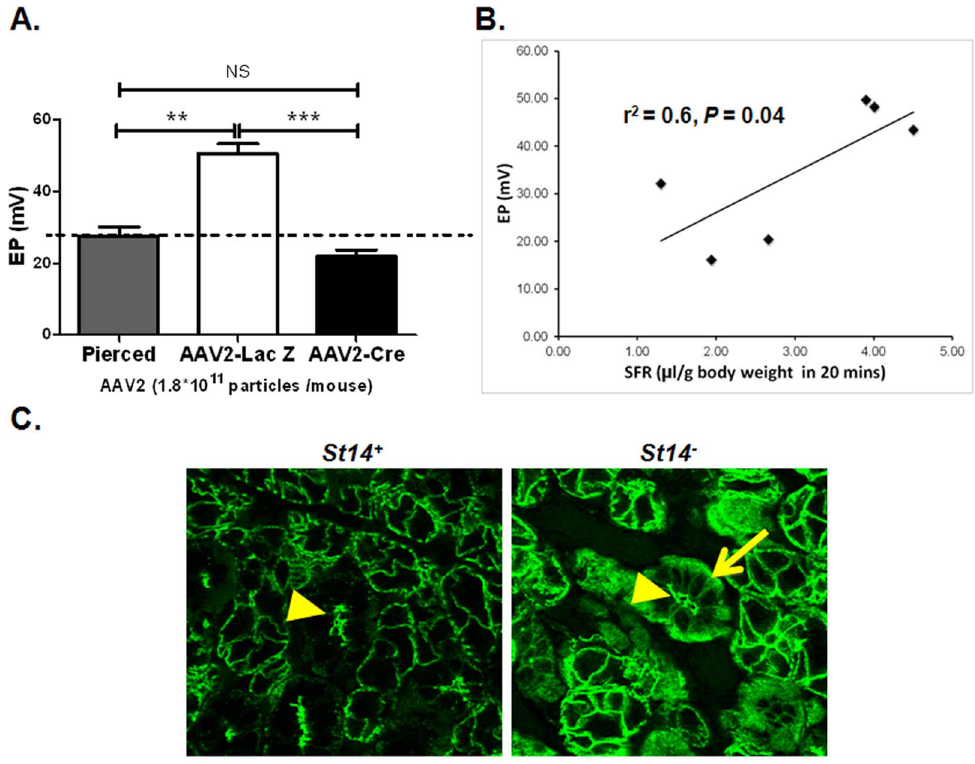
Figure 4. Decreased epithelial electrical potential as well as changes in protein distribution in mice with acute salivary gland- specific ablation of matriptase. Electrical potential (EP) of salivary glands was measured 22 weeks post-AAV2 delivery to glands in live AAV2-Cre ( N= 5) and AAV2-LacZ ( N= 3) mice. Membrane potential of pierced ducts of St14 LoxP/LoxP mice ( N= 2) was used as a control for impaired ductal epithelium. (A) Local depletion of matriptase in SMG from AAV2-Cre animals resulted in a significant EP decrease compared with SMG from AAV2- LacZ control mice. The EP of AAV2-Cre mice was similar to that of pierced glands. (B) Correlation between saliva production and EP of salivary glands from AAV2-Cre mice ( N= 3) and AAV2-LacZ mice ( N= 3). Data shown are the mean 6 SEM for each group. Statistical significance was determined using unpaired Student’s t test and Pearson’s rank correlation test, respectively. NS, P= 0.1978, ** P= 0.0044, *** P , 0.001. (C) Changes in distribution of proteins associated with tight junctions or salivary gland function induced by the loss of matriptase were visualized by immunofluorescent staining of paraffin-embedded SMG tissue samples from St14 – and St14 + control mice 28 to 40 weeks of age ( N= 2 both groups). Representative confocal images are shown. Apical staining of ductal cells for claudin 3 is shown by arrowheads in both St14 + and St14 2 animals. An increase in the signal for claudin 3 was detected in the cytoplasm and basal membrane of ductal cells in St14 – mice compared with St14 + mice, as indicated with arrow; original magnification